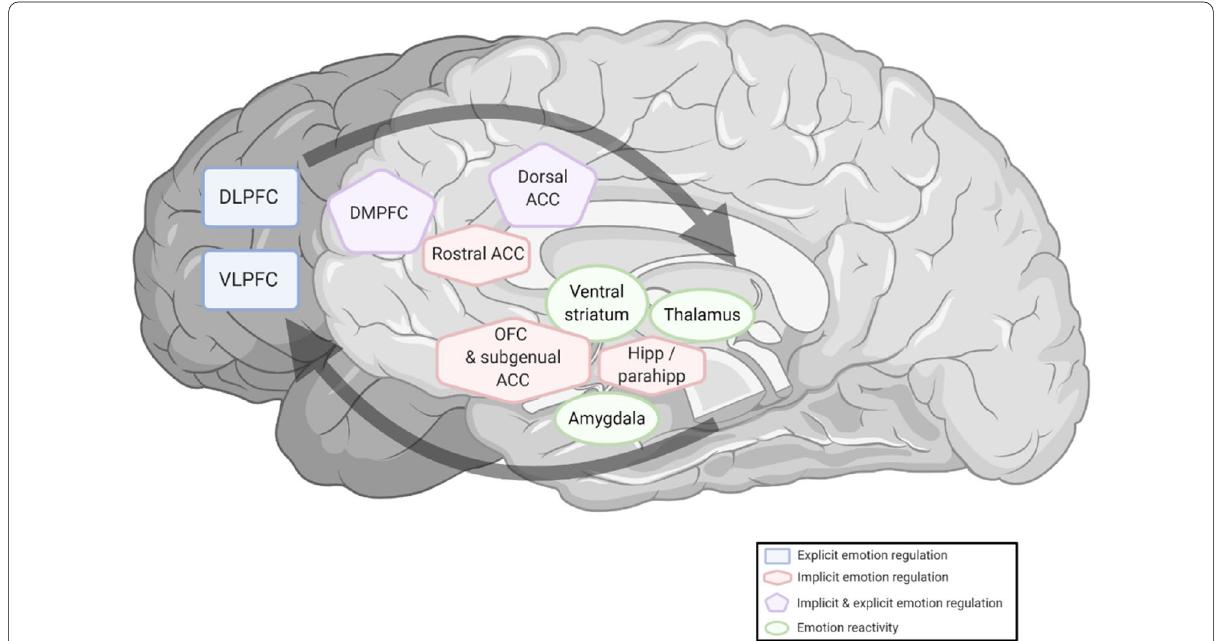
Fig. 1 Simplified neural model of emotion regulation. Illustration of areas involved in emotion reactivity, implicit emotion regulation, and explicit emotion regulation. Black arrows indicate feedforward and feedback mechanisms of these subsystems. Adapted from “A neural model of voluntary and automatic emotion regulation: implications for understanding the pathophysiology and neurodevelopment of bipolar disorder” by Phillips et al. (2008). Created with